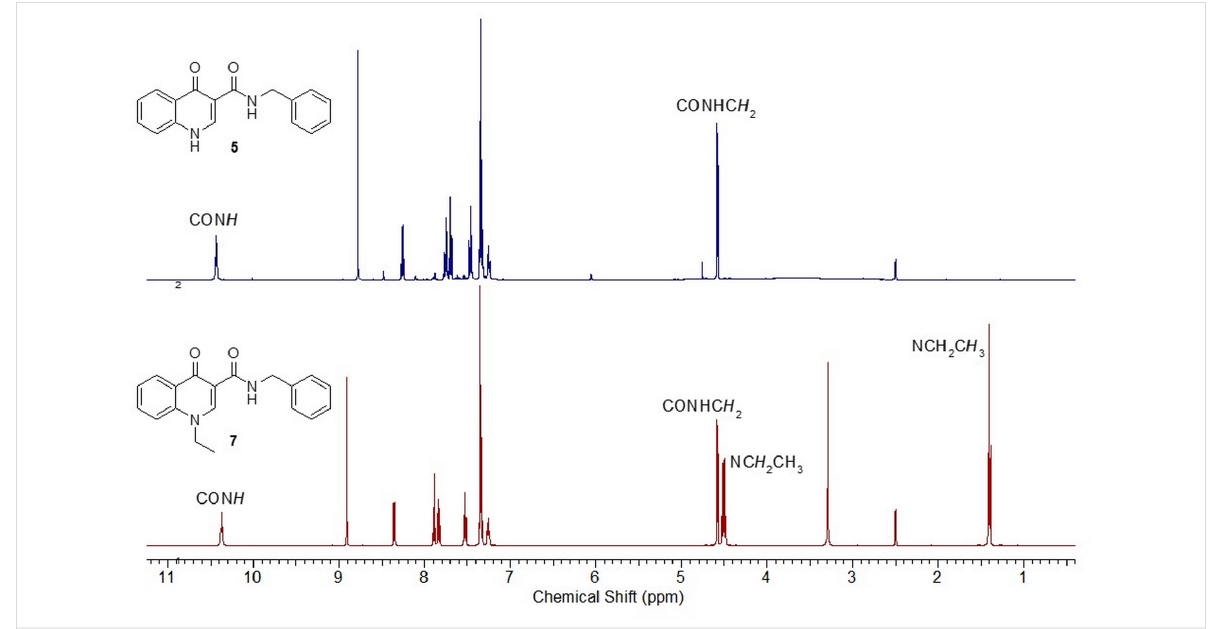
Figure 3: Same scale partial 1 H NMR spectra of compounds 5 and 7 (DMSO- d 6 , 500 MHz).